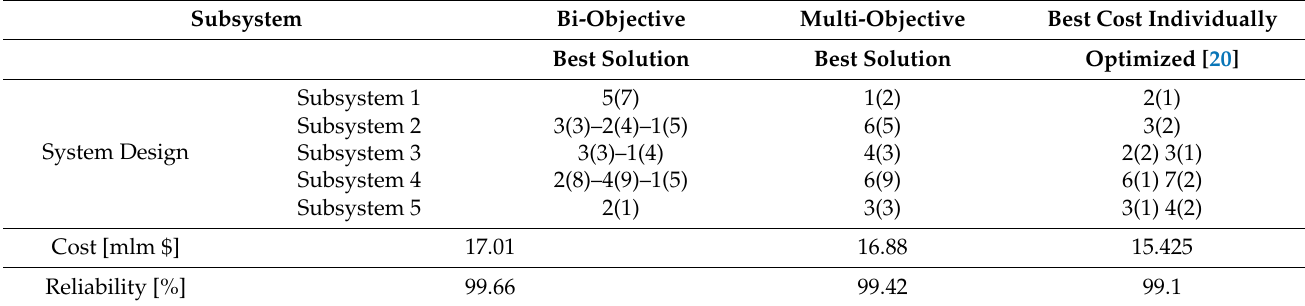
Table 7. Comparison between bi- and multi-objective design values, and individually optimized